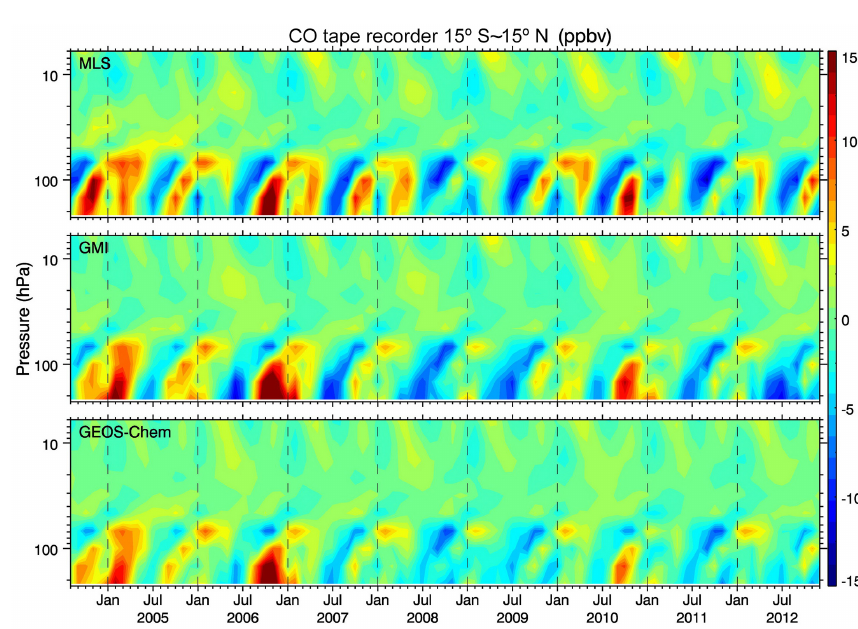
Figure 9. Temporal variation of monthly mean CO deviations, zonally averaged over the tropics (15 ◦ S–15 ◦ N), vertically from 200 to 50hPa for August 2004–December 2012 from (top row) MLS V4 data; (middle row) GMI model simulation with MLS AKs applied; (bottom row) GEOS-Chem model simulation with MLS AKs applied. An 8-year mean (2005–2012) was subtracted from the monthly mean time series at each level for MLS data and the two models’